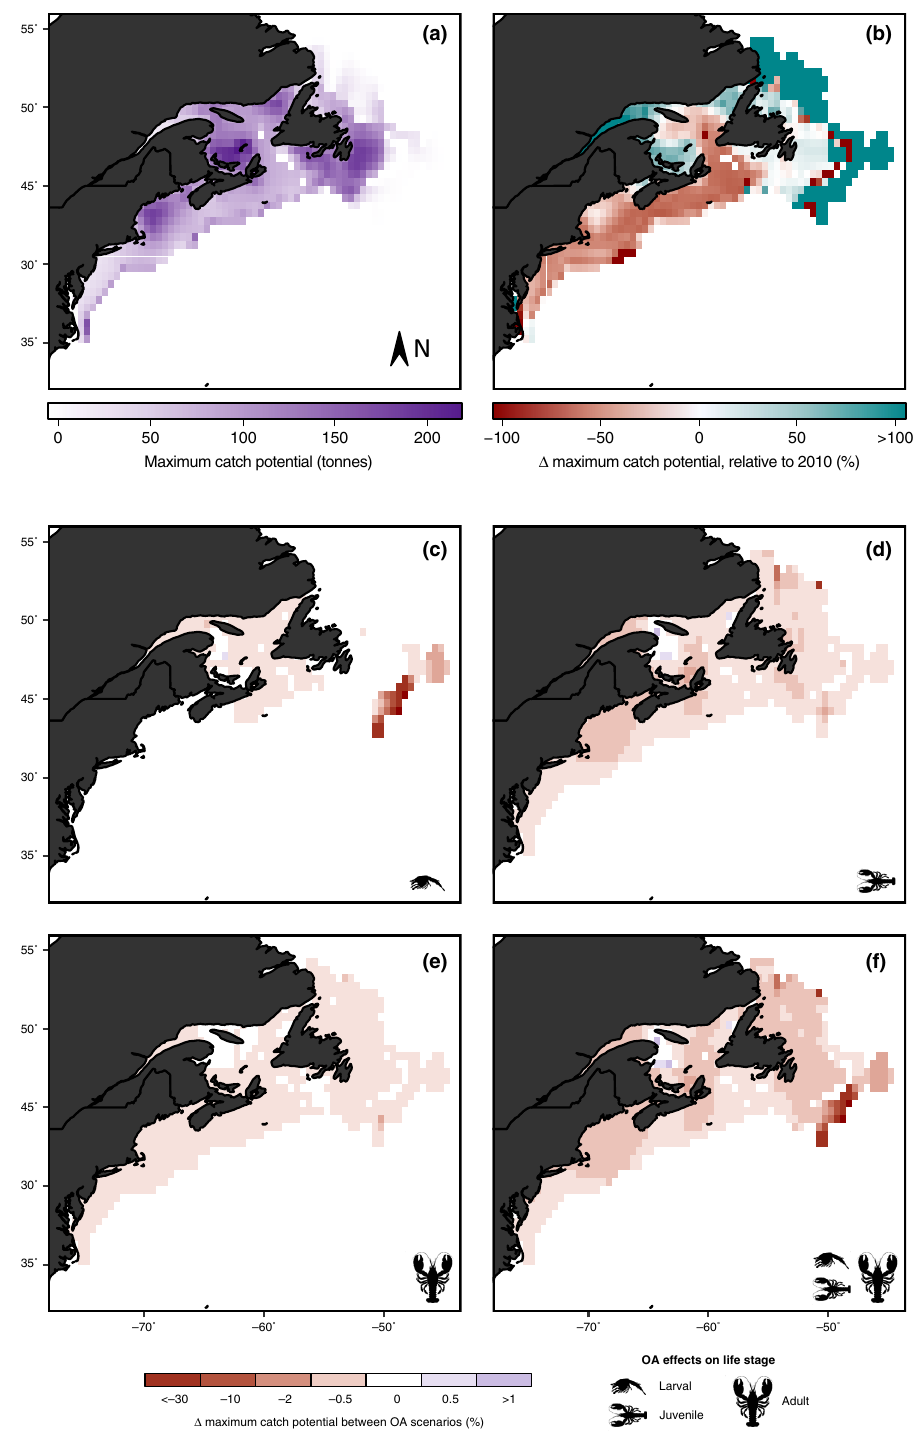
Figure 2. Effects of environmental change on the distribution of maximum catch potential for H. americanus at the end of the twenty-first century (2091–2100) in a high climate change scenario (RCP 8.5). The top two panels show the null model effects of environmental change without any OA effects (i.e. changes due to temperature, oxygen content, primary production): ( a ) estimated maximum catch potential in year 2100, and ( b ) the change in maximum catch potential relative to 2010. Panels ( c )–( f ) represent the change in catch potential due to the added effects of OA, relative to the null model (panel a ), on the different life stages (larval, juvenile, adult). Results are from simulations using the GFDL Earth system model and are the annual average across 10 years. Other parameter values (Table 1): OA mortality effect size = 15%; fishing pressure = MSY; fishing size limit =